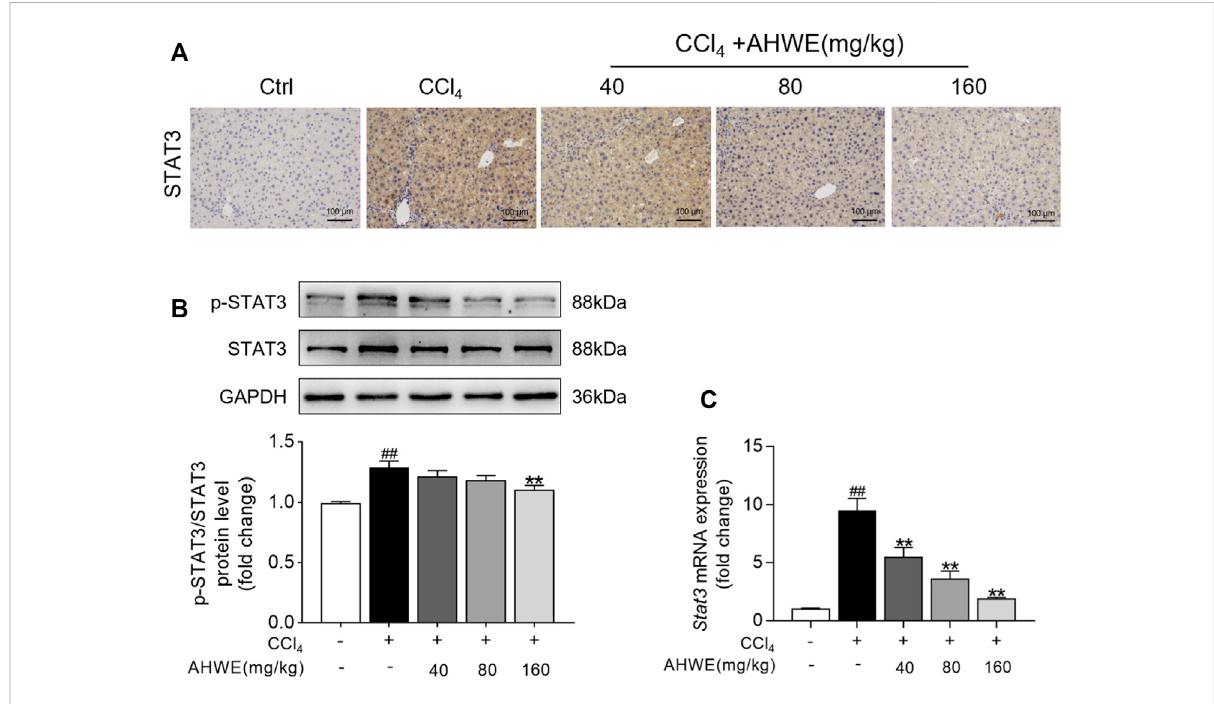
FIGURE 7 AHWE was able to regulate STAT3 signaling pathway to attenuate HF. (A) The representative photomicrographs of immunohistochemistry staining of STAT3 in paraf fi n-embedded liver samples. (B) Western blot and densitometric analysis of STAT3, p-STAT3 and GAPDH; (C) Q-PCR for STAT3. For the statistics of each panel in this fi gure, data are expressed as mean ± SD ( n = 3). # p < 0.05 and ## p < 0.01 vs. control group; p p < 0.05 and pp p < 0.01 vs. CCl 4